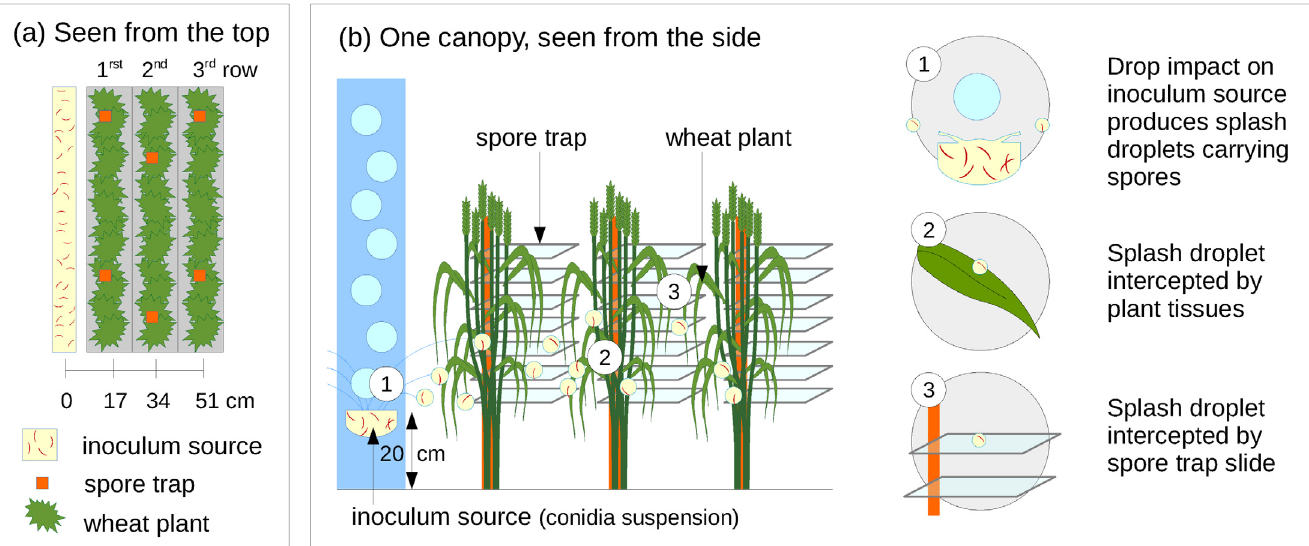
Fig 2. Production of standardized splash droplets and interception by plant canopy. The experimental arrangementis representedhere, seen from the top (a) and from the side (b). Calibrated raindropswere generated by a rain simulatorand fell on a linear inoculumsource constituted of a conidia suspension with a concentration of 1.6 × 10 6 conidiaper mL. Splash droplets traveledthrough the canopy, some were intercepted by plant tissues or spore trap slides. After a latency period, diseasesymptoms were observed.They resultedfrom the numberof intercepted spores and from leaf susceptibility. Both spore fluxes and diseasesymptoms were measuredon 10 plants per canopy